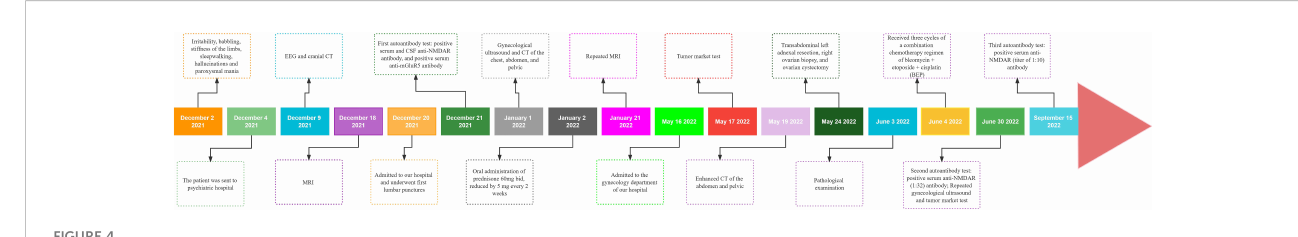
FIGURE 4 Timeline with clinical manifestation, treatment progression, and diagnosis